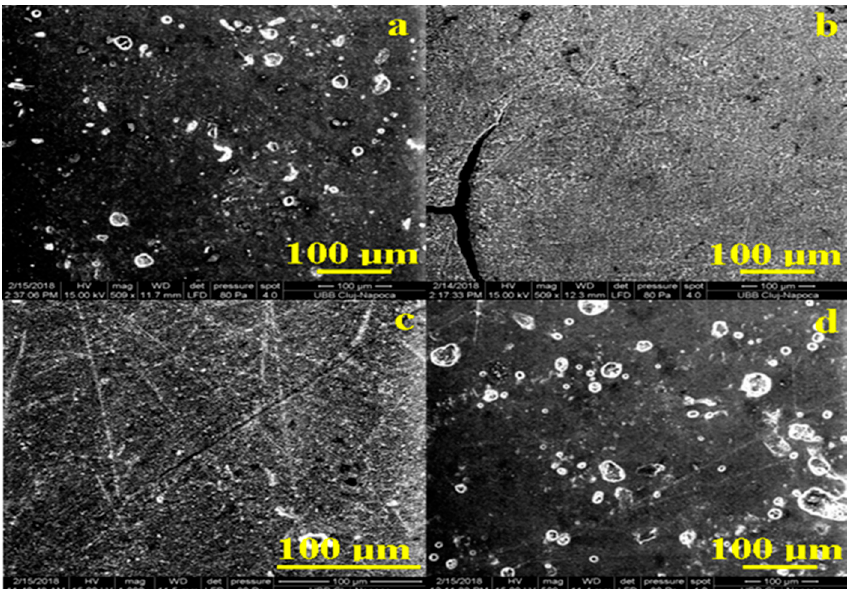
Figure 3. SEM images of the samples exposed 44 days to artificial saliva: ( a ) Adoro, ( b ) Variolink, ( c ) Relyx, and ( d ) Solidex captured with 500× and 1000× magnitude.